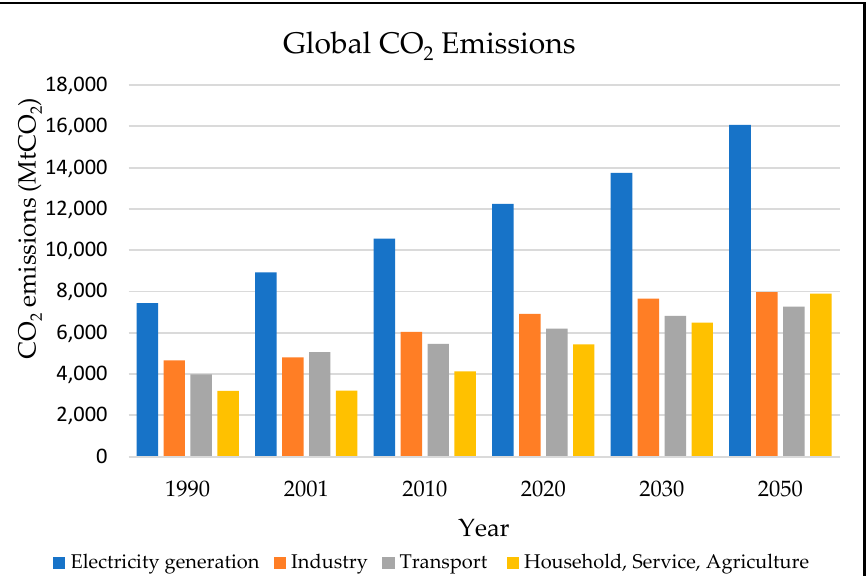
Figure 1. Global CO 2 emissions (data source: World Energy Technology Outlook 2050 [3]).